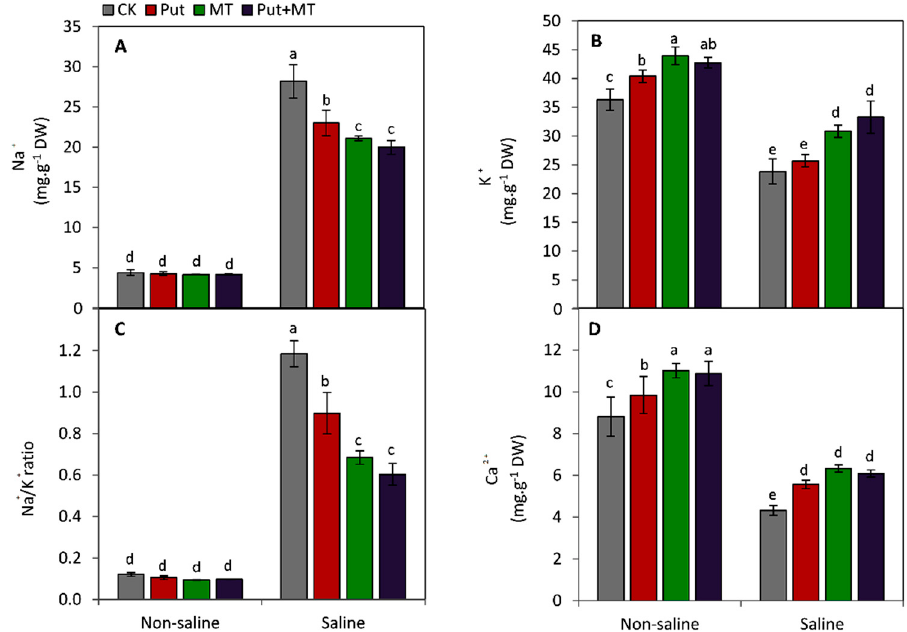
Figure 3. Effect of melatonin (MT; 20 µ M), putrescine (Put; 100 µ M), and their combination on the nutrient homeostasis of snap bean seedlings grown under control and salt stress (50 mM NaCl). ( A ) Na, ( B ) K, ( C ) Na/K ratio, and ( D ) Ca. The upper error bar denotes standard deviation, while various lowercase letters above the bars denote significant differences according to Duncan’s multiple range tests ( p ≤ 0.05).